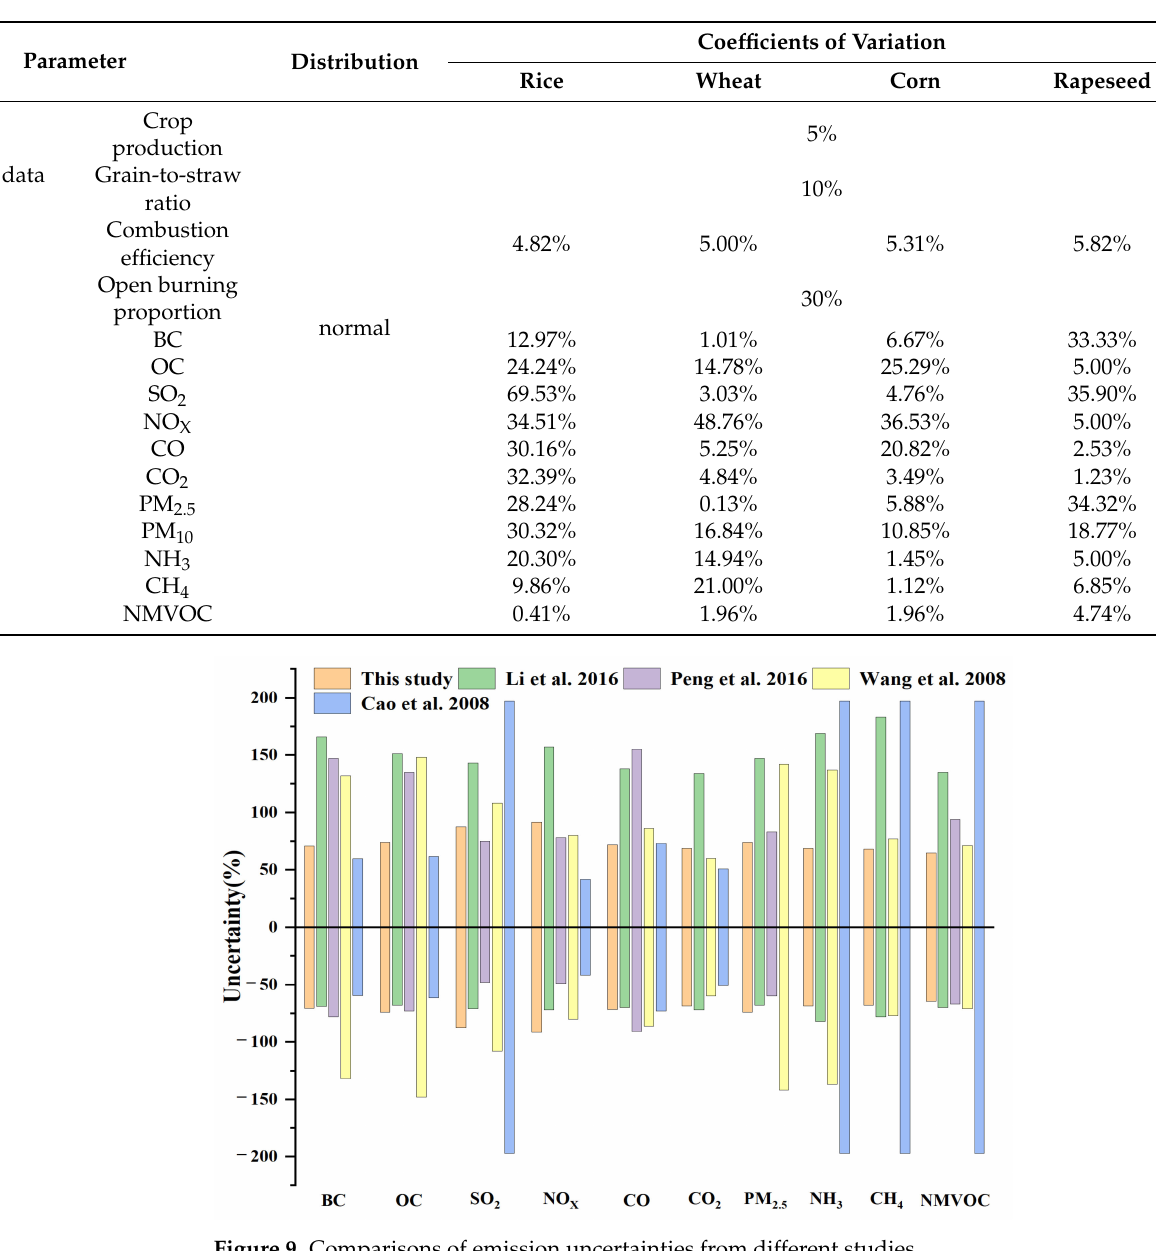
Figure 9. Comparisons of emission uncertainties from different